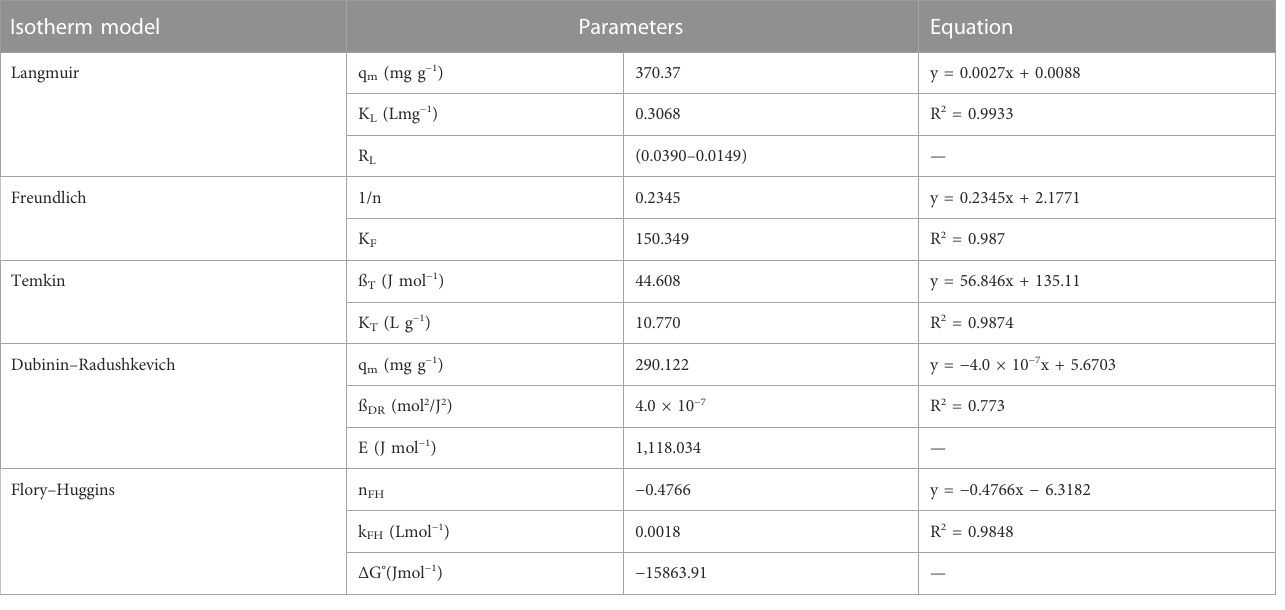
TABLE 2 Adsorption isotherm parameters of the sorption of acid red 37 dye by CM- β CD:nChi:Glu. Isotherm model Parameters